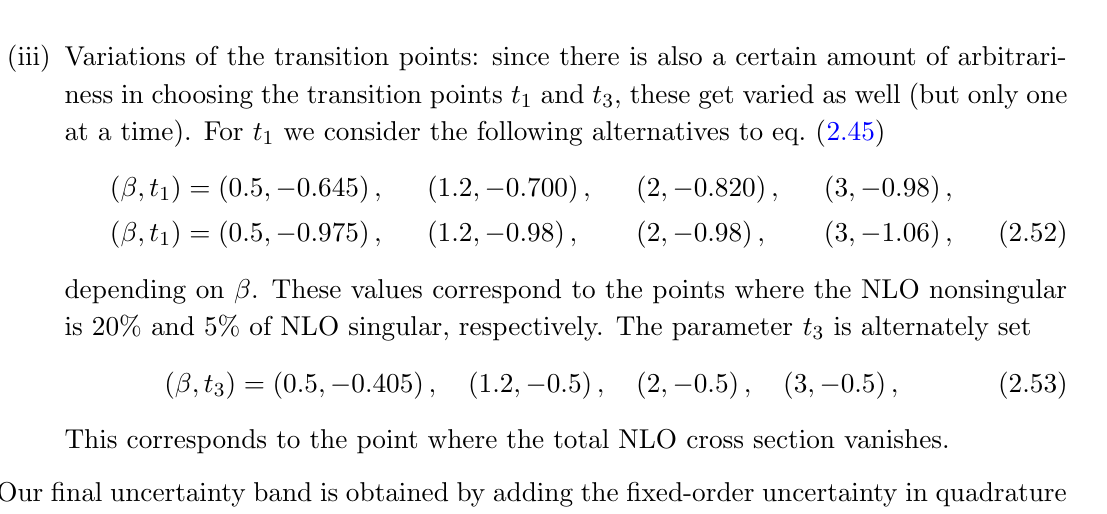
Table 2 . Canonical scales for the measurement of two angularities in the three regions, with L (cid:17) log e L (cid:17) log e (cid:11) (cid:11) and (cid:12) (cid:12) 10 10